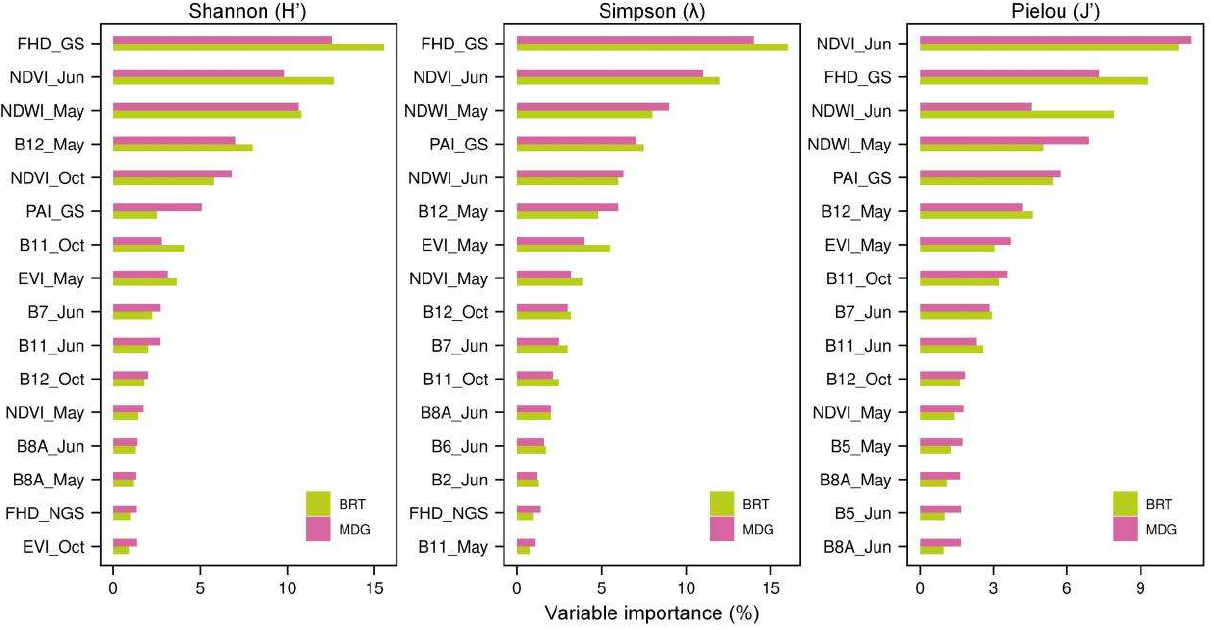
Figure 2. Relative importance of the features selected for estimations of forest diversity indices.